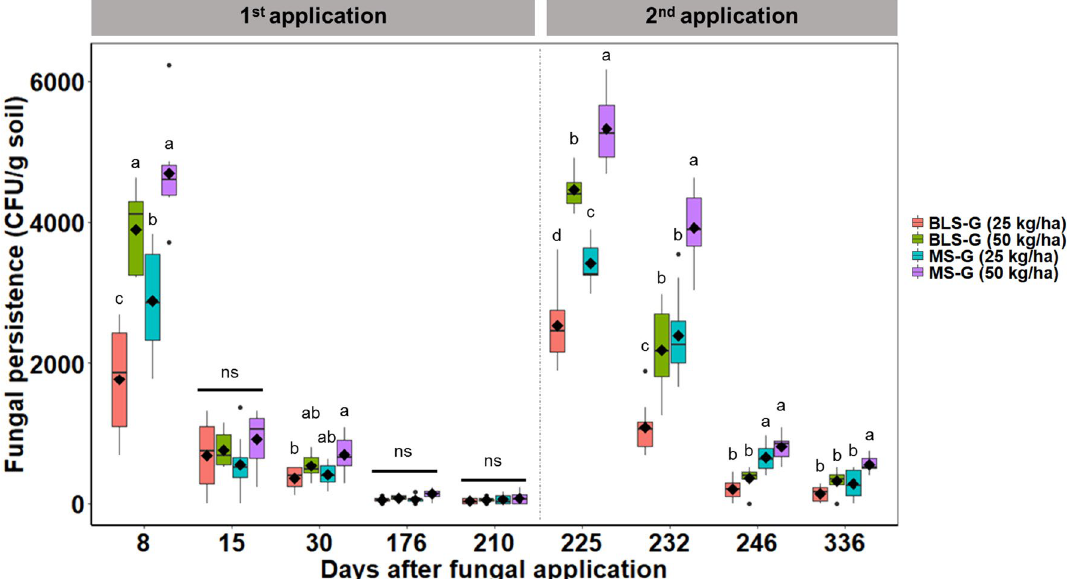
Figure 2. Fungal persistence in the soil of pots treated with Metarhizium robertsii granular formulations. Box plot of M. robertsii colony forming units (CFUs) per gram of soil obtained after the 1st and 2nd fungal application under field conditions. Boxes show the median, 25th and 75th percentiles, while error bars show 10th and 90th percentiles. Means (n = 8) are black diamonds and followed by distinct letters indicate a significant difference between treatments (Tukey HSD test P < 0.05). BLS-G: granular blastospores formulation; MS-G: granular microsclerotia